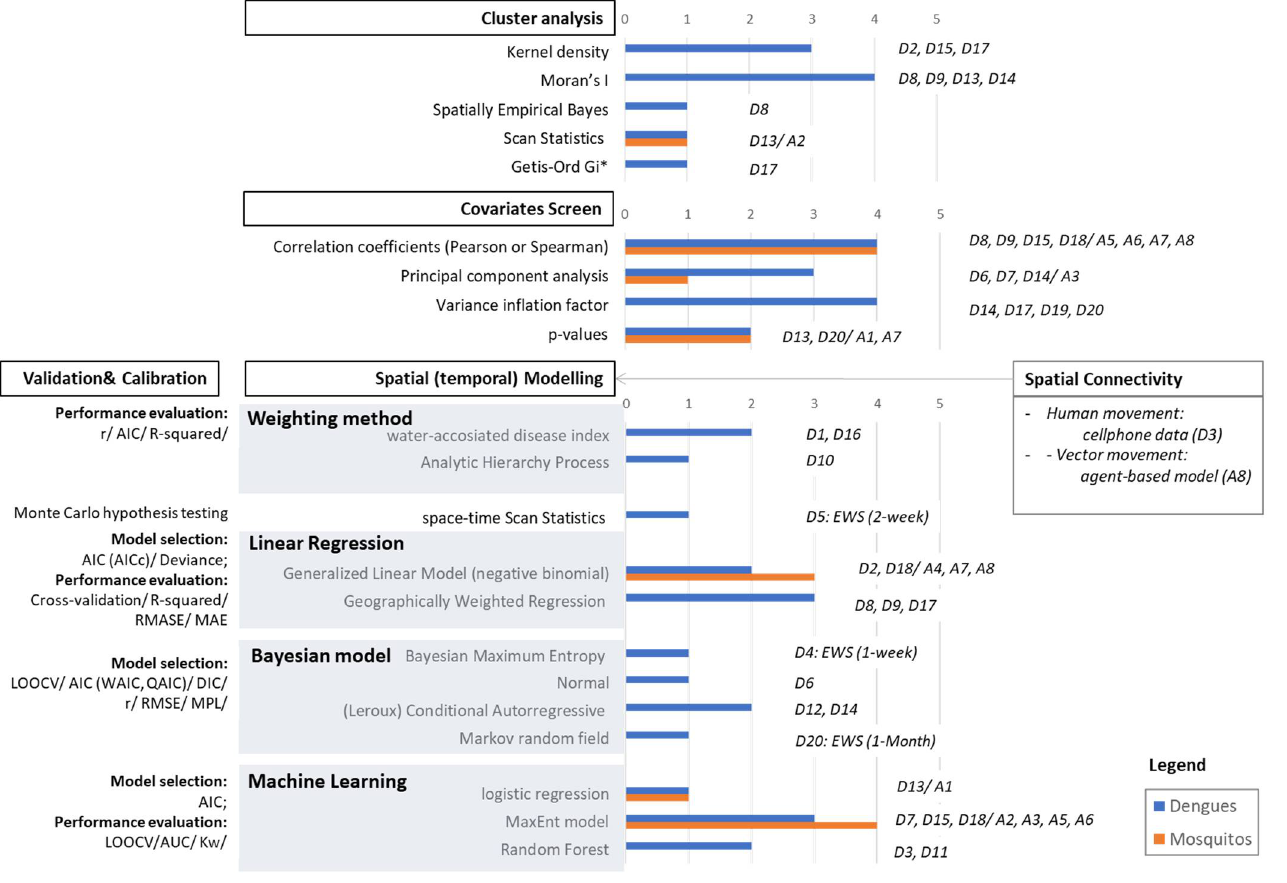
Figure 4. The modeling approaches of cluster analysis, covariates screen, spatial or spatio-temporal modeling, spatial connectivity, and validation methods in selected studies.